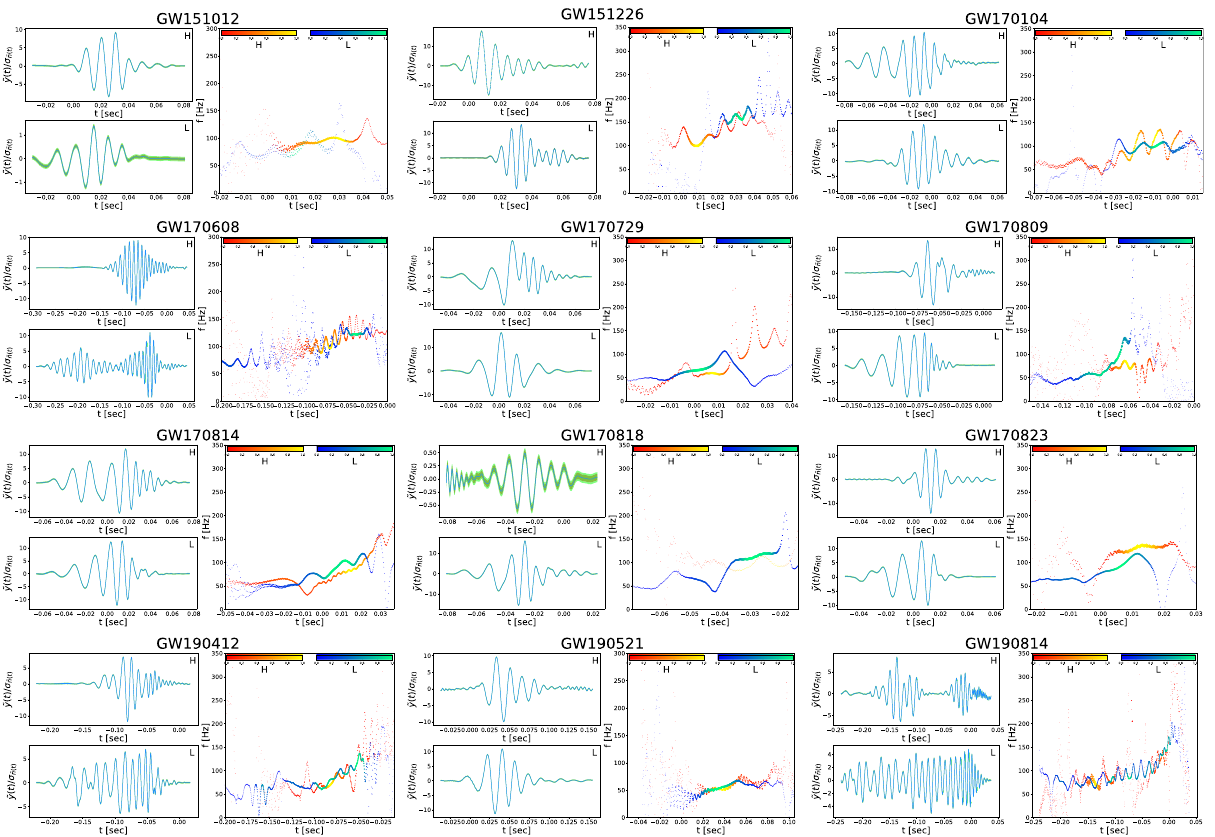
Figure 4. Extracted waveforms of binary black-hole mergers in observing runs O1, O2 and O3a. Extracted waveforms of binary black-hole mergers in O1, O2, and O3a observing runs. They are labeled by the event name and detector that received the signal. The strains are given in units of the standard deviation of the processed background noise. For extracted waveforms in H, L, and V, the Hilbert spectrum’s instantaneous frequencies are plotted. The cross-correlation coefficients (R) of extracted waveforms are given in Table 1. We set the time to zero at the event GPS time reported by LIGO. We excluded waveforms of the GW170817 and the